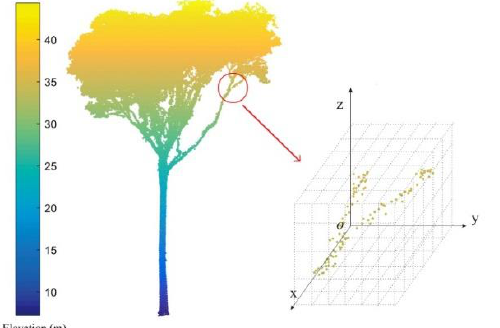
Figure 1. Schematic diagram of fractal dimension calculation 2.2 Zenith angle and variation feature vectors